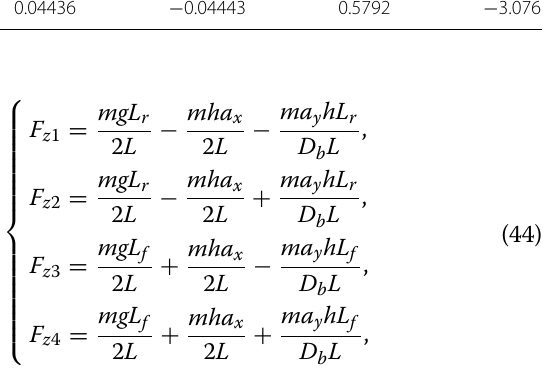
Table 1 The offline fitted lateral Magic Formula parameters Cy b